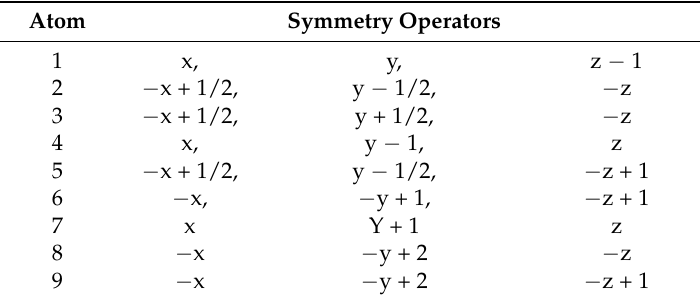
Table A3. Definitions of symmetry operators.